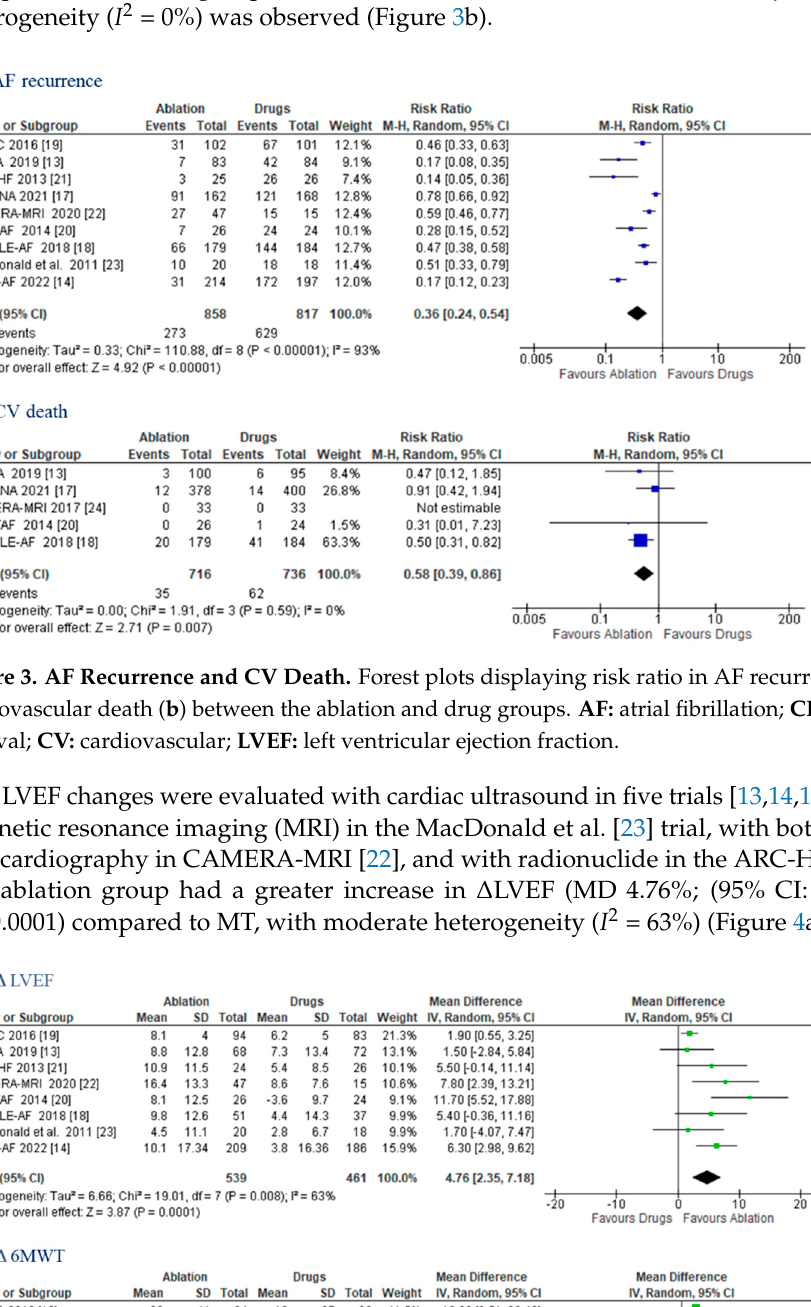
Figure 2. Composite Endpoint, All-Cause Mortality, HF Hospitalizations. Forest plots displaying a decrease in the composite endpoint ( a ), all-cause mortality ( b ), and HF hospitalizations ( c ) in patients with AF and HF undergoing CA versus MT. CI: confidence interval; HF: heart failure.